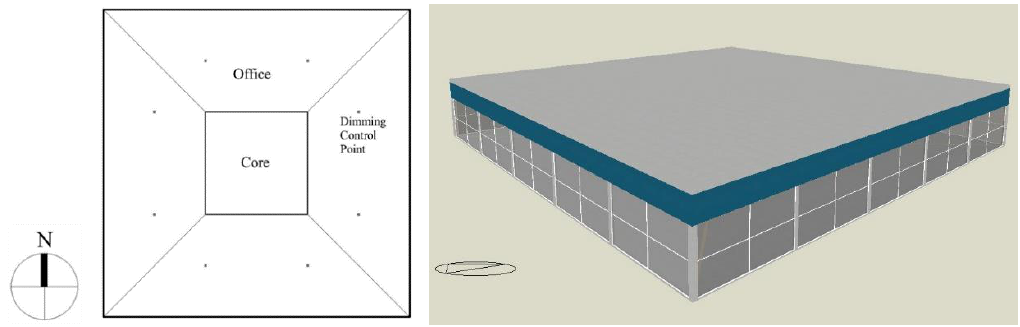
Figure 1. Unit plan and modeling image of simulation. Table 1. Window-to-wall ratio (WWR) and window-to-floor ratio (WFR) in building of floor height 4.2 m and ceiling